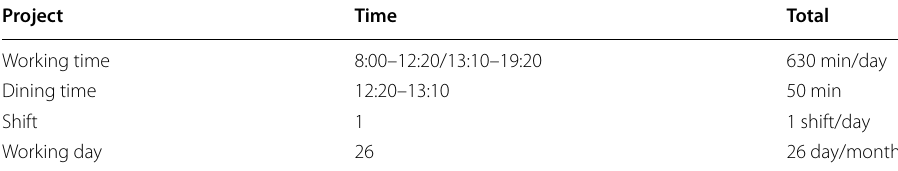
Table 2 Working time